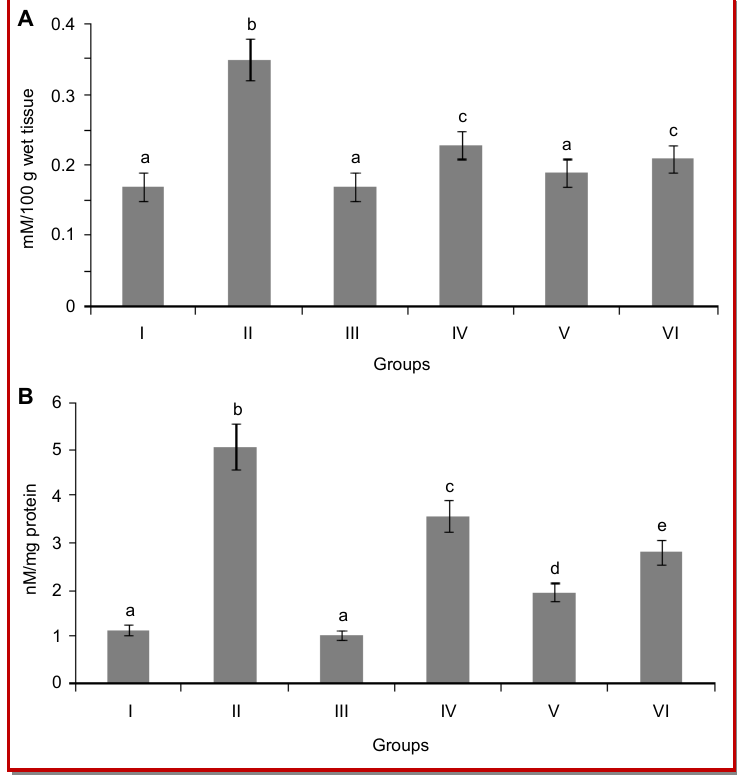
Figure 2: Level of peroxidation products in heart tissue. (A) TBARS; (B) Protein carbonyl value. Values are mean ± SD for six rats in each group. Values not sharing a common superscript differ significantly at p<0.05